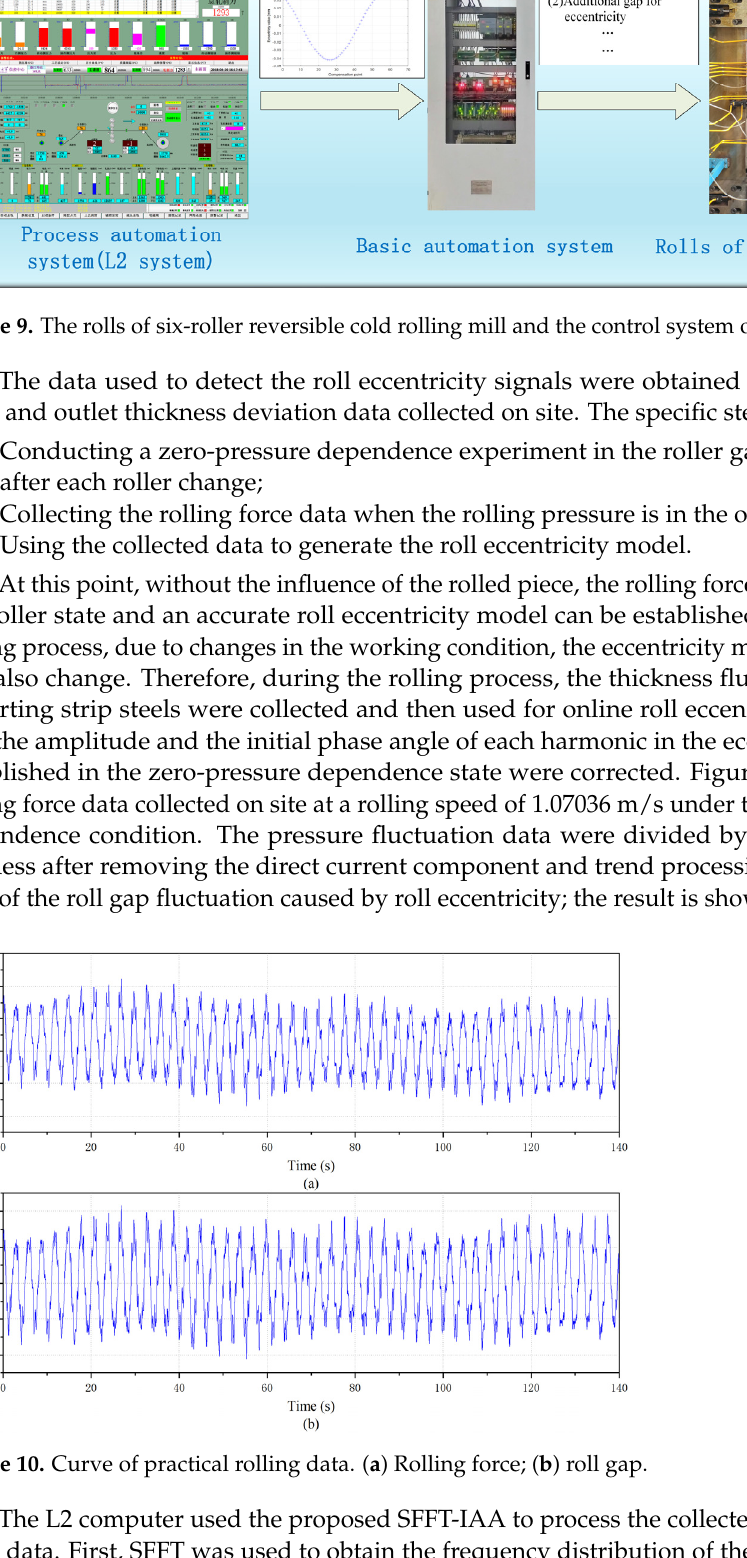
Figure 11. The results of practical data by SFFT. It can be seen from Figure 11 that the frequency components of the measured data were concentrated around 0.33 Hz, 0.63 Hz, 1.73 Hz, and 2.1 Hz, especially around 0.33 Hz, where the component with the largest frequency spectra peak was located. Consider- ing this, four small frequency ranges were set in this study, which were [0.30 Hz 0.36 Hz], [0.60 Hz 0.66 Hz], [1.70 Hz 1.76 Hz], and [2.07 Hz 2.13 Hz]. In each frequency band, the roll eccentricity parameters were estimated by the IAA algorithm; the results are illus- trated in Figure 12.